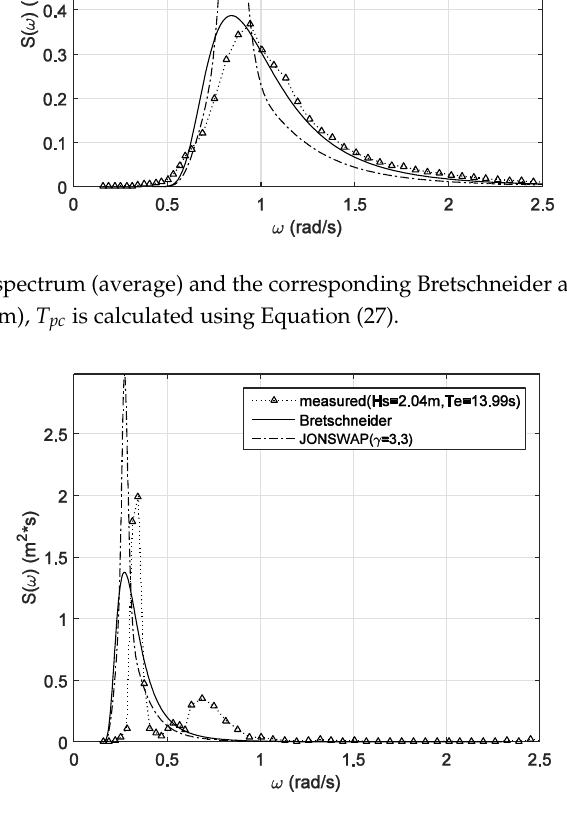
Figure 17. Measured spectrum (average) and the corresponding Bretschneider and JONSWAP spectra ( T e = 13.99 s, H s = 2.04 m), T pc is calculated using Equation (27).